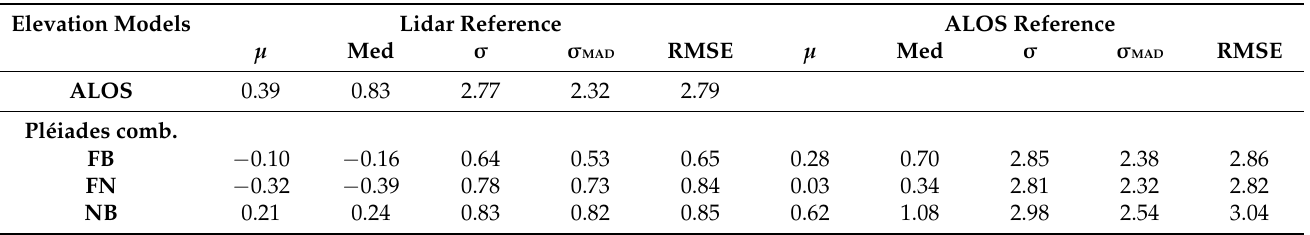
Table 7. ALOS vertical accuracy with reference to Lidar and comparison of Pléiades DEMs with respect to Lidar and ALOS in open areas (given values are in